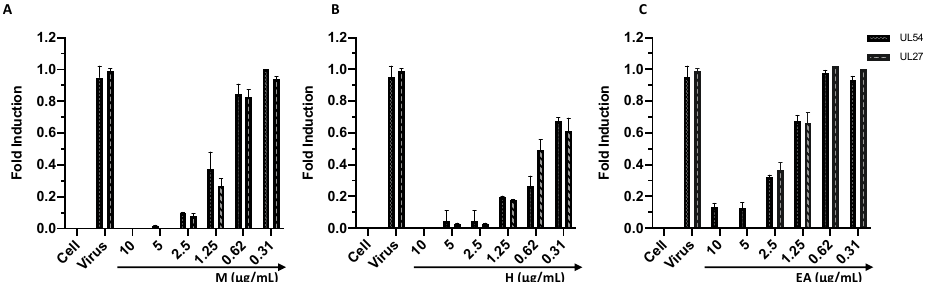
Figure 5. Analysis of HSV-1 UL27 and UL54 expression levels after treatment with M ( A ), H ( B ), and EA ( C ). Data represent the mean ± standard deviation (SD) of three independent experiments.